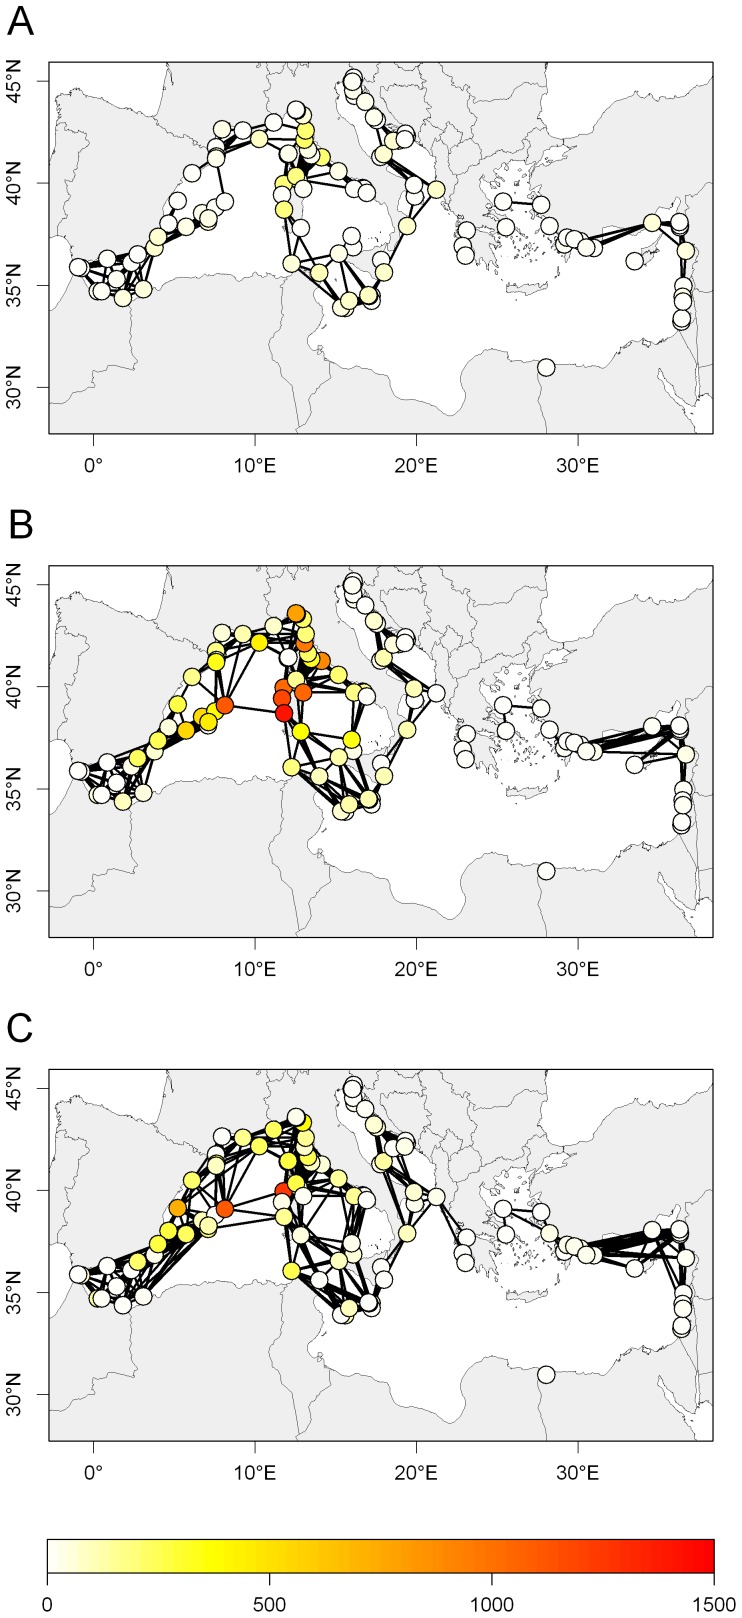
Betweenness centrality of MPAs.A, PLD = 20 days; B, PLD = 30 days; C, PLD = 40 days.